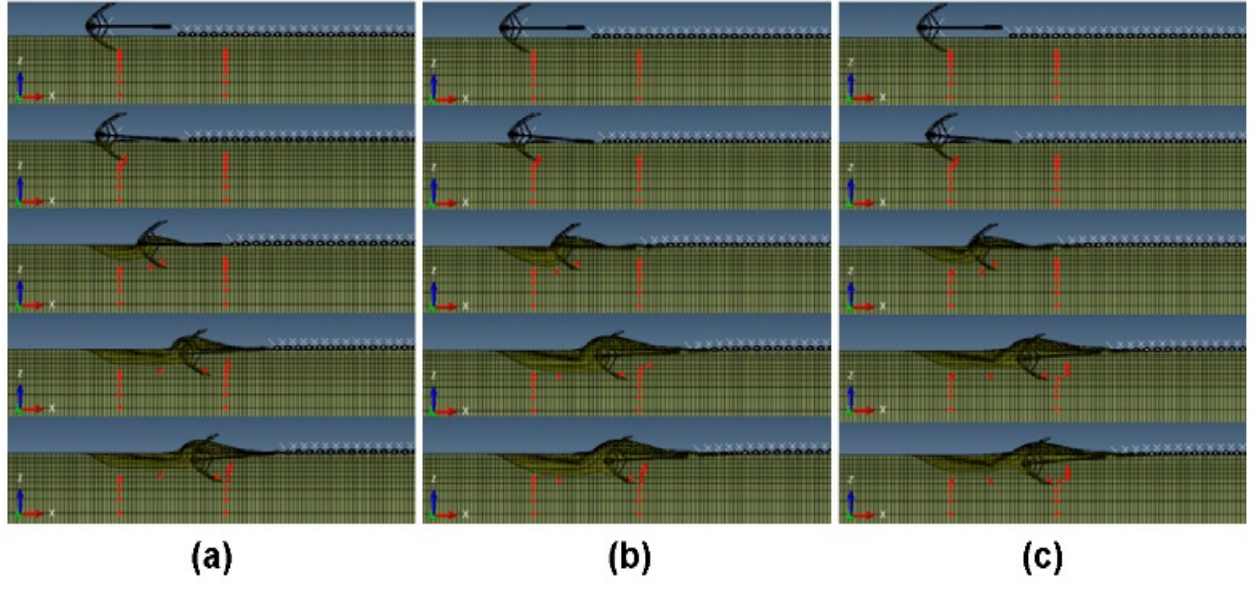
Figure 13. Results of TBSR–VUMAT and M–C models. ( a ) M–C model, ( b ) TBSR–VUMAT model in the rate-dependent case, and ( c ) TBSR–VUMAT model in the rate-independent case.